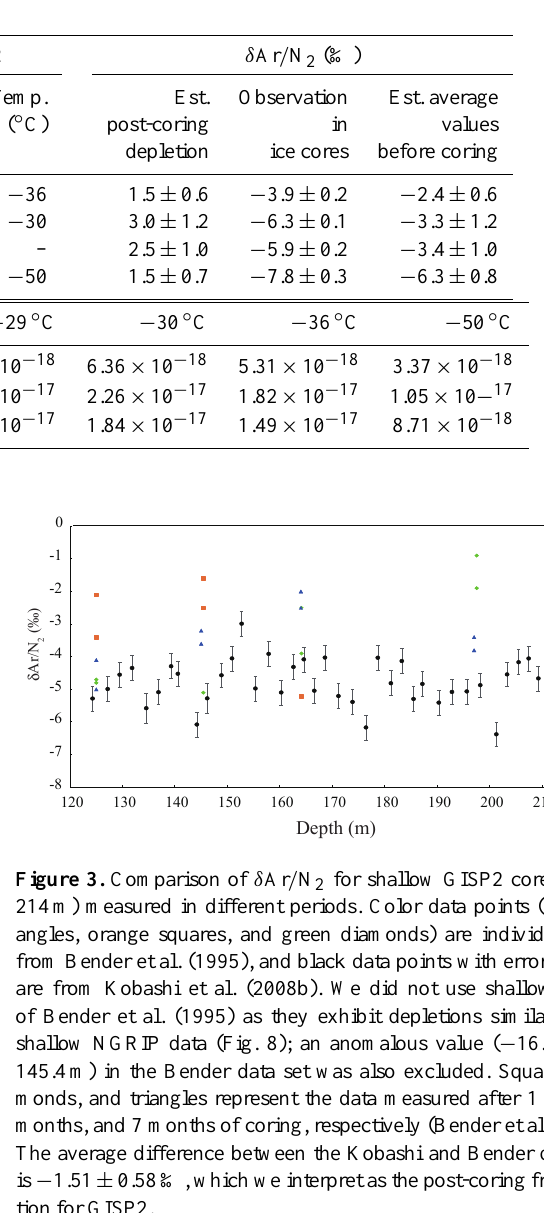
X N and k Ar X Ar (ms − 1 molmol − 1 MPa − 1 ) ice 2 2